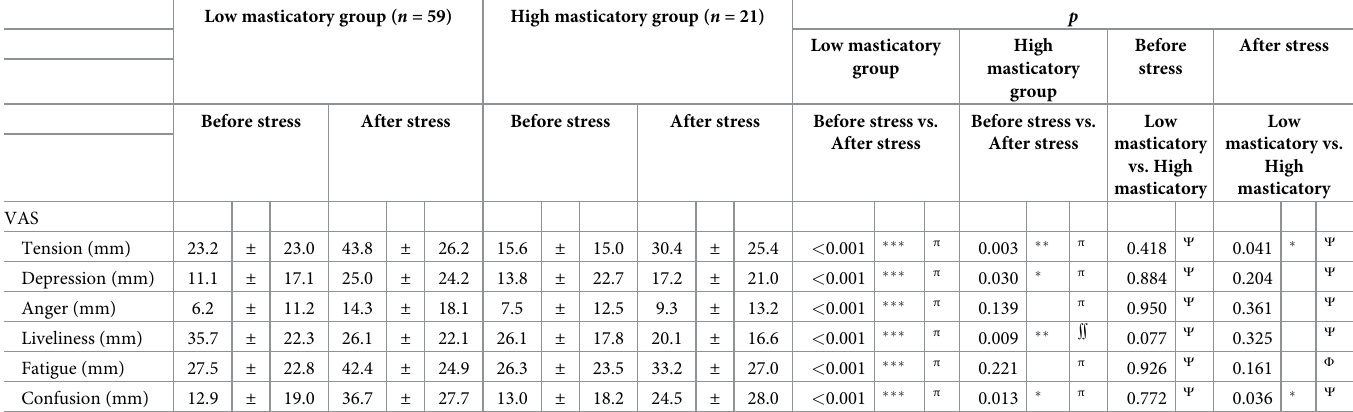
Table 2. Visual analog scale (VAS) scores. Low masticatory group ( n = 59) High masticatory group ( n = 21) Before stress After stress Before stress After stress Before stress vs.